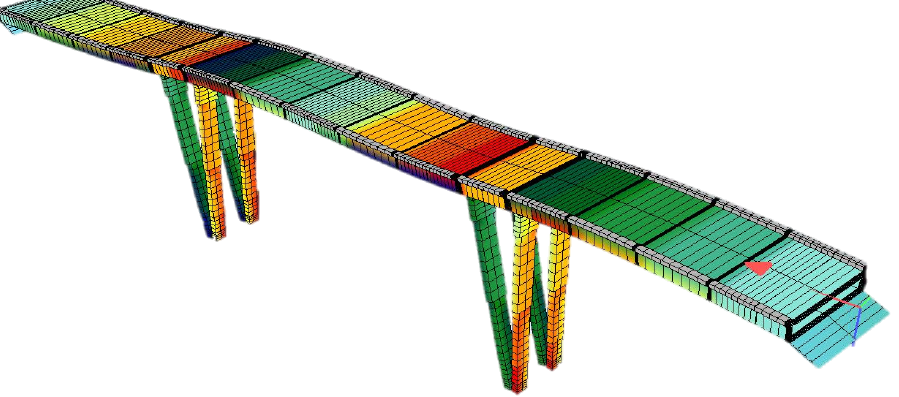
Figure 8. Numerical model of the Case Study bridge, first modal shape (longitudinal). Table 4. Modal parameters for first Case Study bridge, obtained using linear analysis.